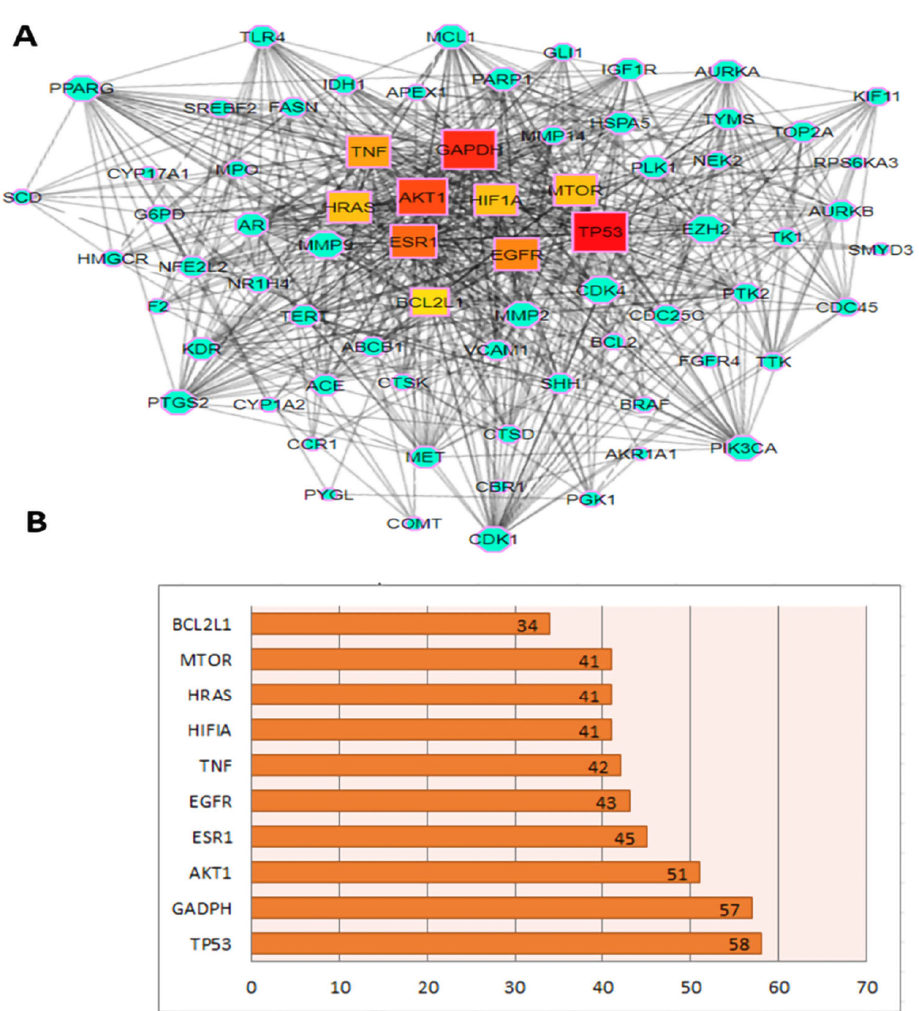
Figure 2. ( A ) PPI network analysis. Central square nodes represent the targets with a higher degree (hub genes), the color from red to yellow and node size set according to their degree score; the rest of the blue nodes were other key targets. ( B ) The bar plot drawn based on the degree score represents the hub genes.